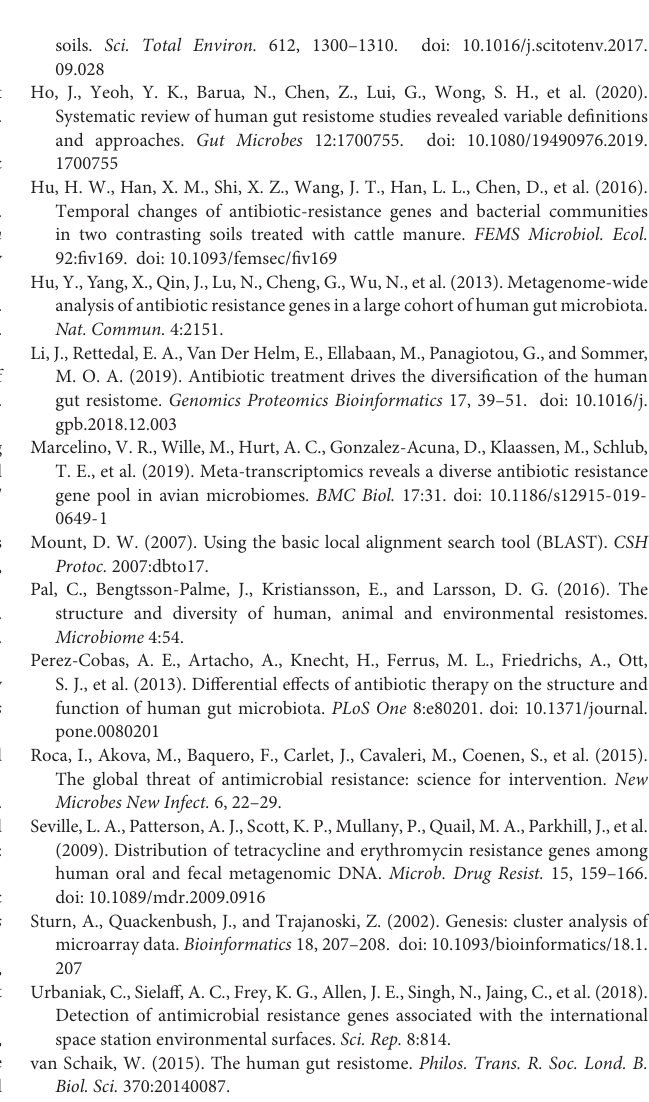
Supplementary Table 3 | Detailed results from the mapping of Shotgun Metagenomic Sequencing (SMS) against the NCBI’s AMR reference gene Supplementary Table 4 | Identification of contigs carryings antimicrobial resistance genes using (i) the ResFinder 3.1 tool and (ii) the SMS + BLAST